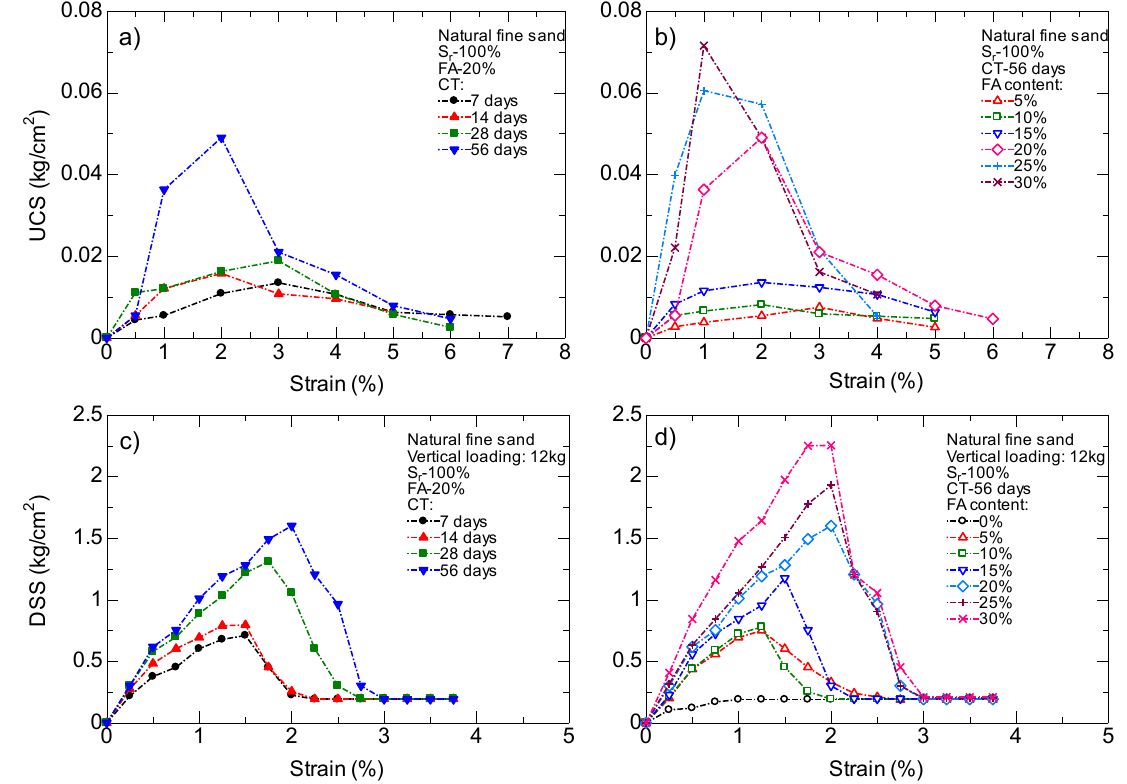
Figure 2. Stress–strain relationships on natural fine sand at S r -100%. ( a ) stress–strain curve of UCS at various CT with 20% FA, ( b ) stress–strain curve of UCS at di ff erent FA with CT-56 days, ( c ) stress–strain curve of DSS at various CT with 20% FA, and ( d ) stress–strain curve of DSS at di ff erent FA with CT-56 days.